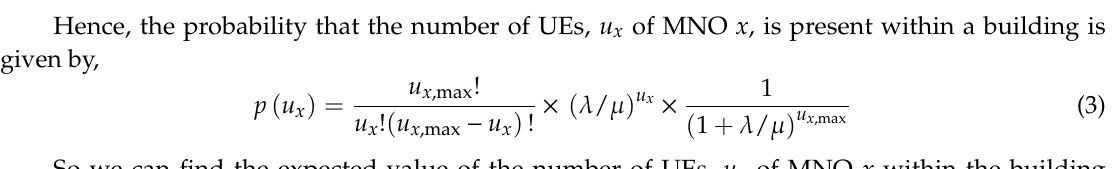
, using Equation (1), the following could be obtained.